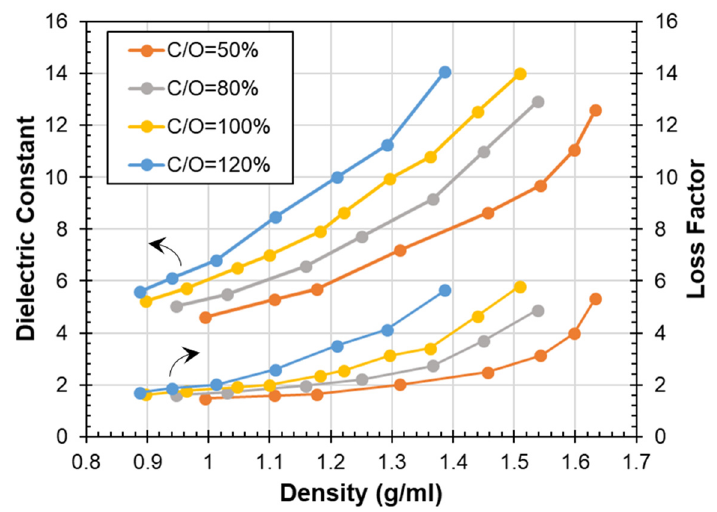
Figure 6. Dielectric properties of samples with different carbon content as a function of density.